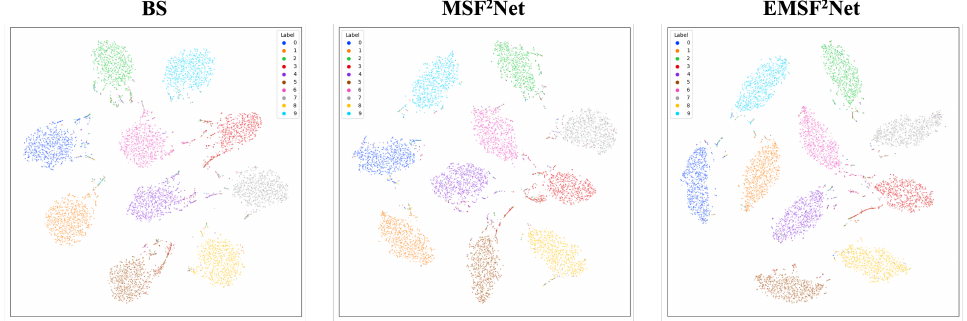
Figure 8. t-SNE visualization results of the baseline, MSF 2 Net, and EMSF 2 Net without any attacks on the CIFAR-10